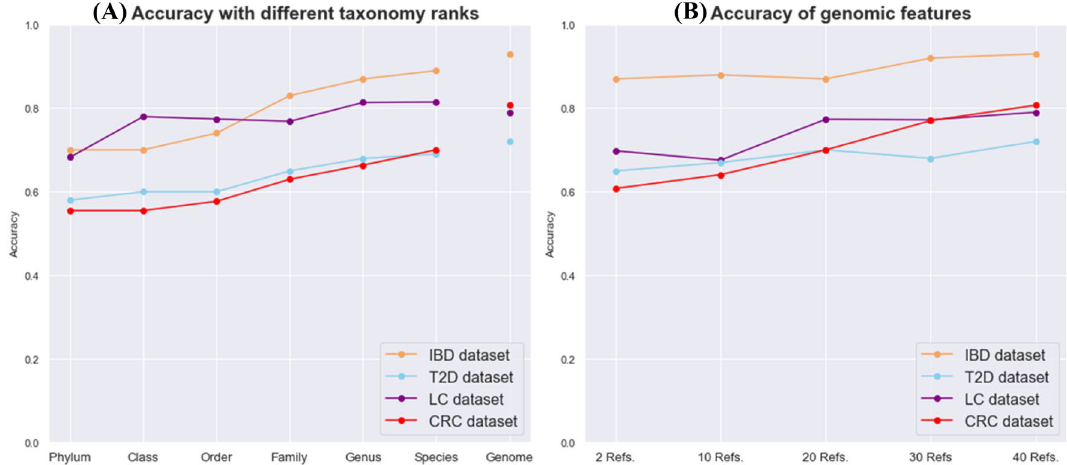
Figure 5. Accuracy with different levels of relative abundance features. (A) Accuracy of conventional taxonomic features from phylum-level to species-level and genomic features generated with 40 reference features for comparison. (B) Accuracy of genome-level features with different numbers of reference samples. Each data point is an average accuracy of three runs conducted with different reference samples. Each run represents an average accuracy of five iterations of LOOCV. Orange, blue, purple, and red lines correspond to the IBD, T2D, LC, and CRC datasets, respectively.